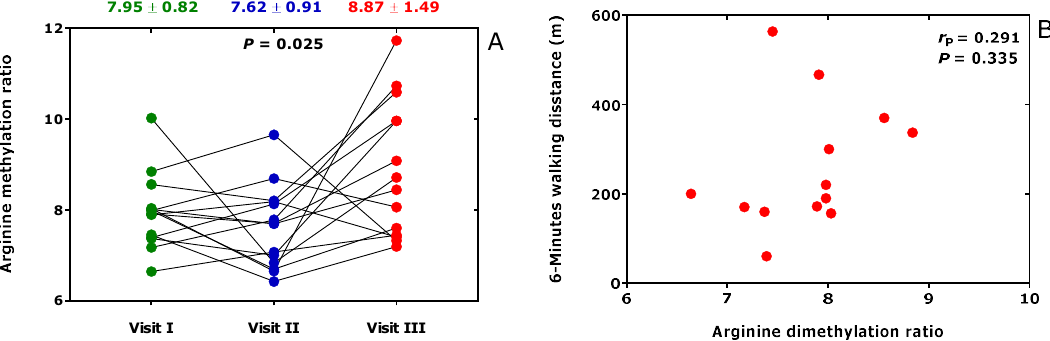
Figure 8. ( A ) Arginine dimethylation ratio, the molar ratio of the sum of the urinary concentration of asymmetric dimethylarginine (ADMA) and dimethylamine (DMA) and of the urinary concentration of symmetric dimethylarginine (SDMA) (ADMA + DMA/SDMA), at baseline (Visit I), after six-weeks treatment (Visit II) with metformin (3 × 500 mg/d) or L-citrulline (3 × 5000 mg/d) and subsequent six- weeks treatment (Visit II) with (3 × 500 mg/d) plus L-citrulline (3 × 5000 mg/d). ( B ) Relationship of the six-min walking distance in patients with Becker muscular dystrophy and the Arg dimethylation ratio